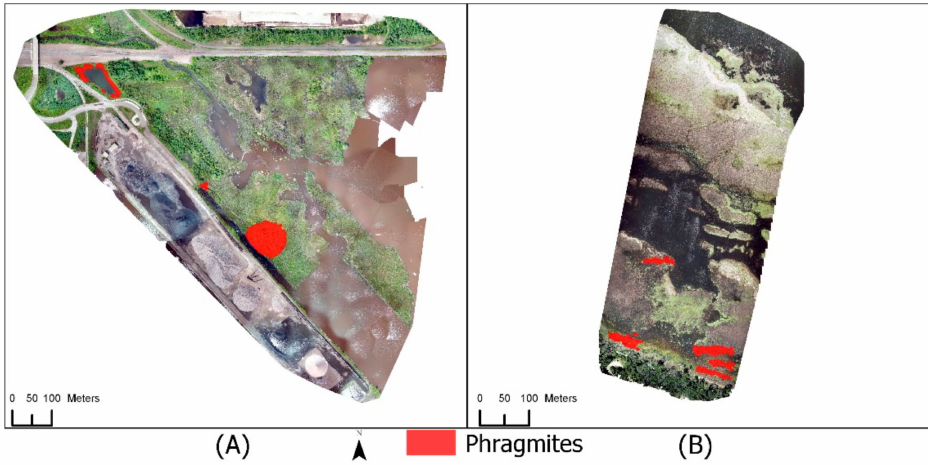
Figure 3. Known patches of Phragmites within the ( A ) Grassy Point Park study site and ( B ) the Saginaw Bay site. Three patches are present in Grassy Point Park, while five patches are present in the Saginaw Bay study